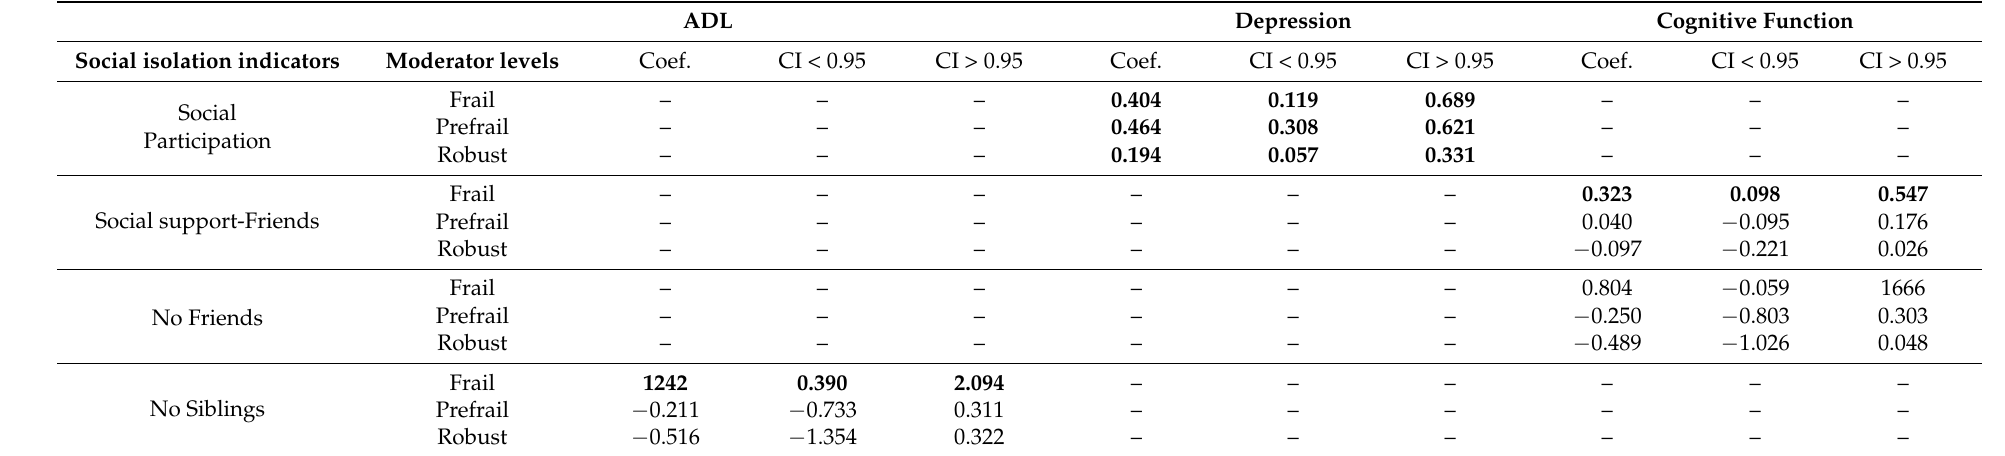
Table 5. Conditional effects of social isolation on health outcomes at different values of